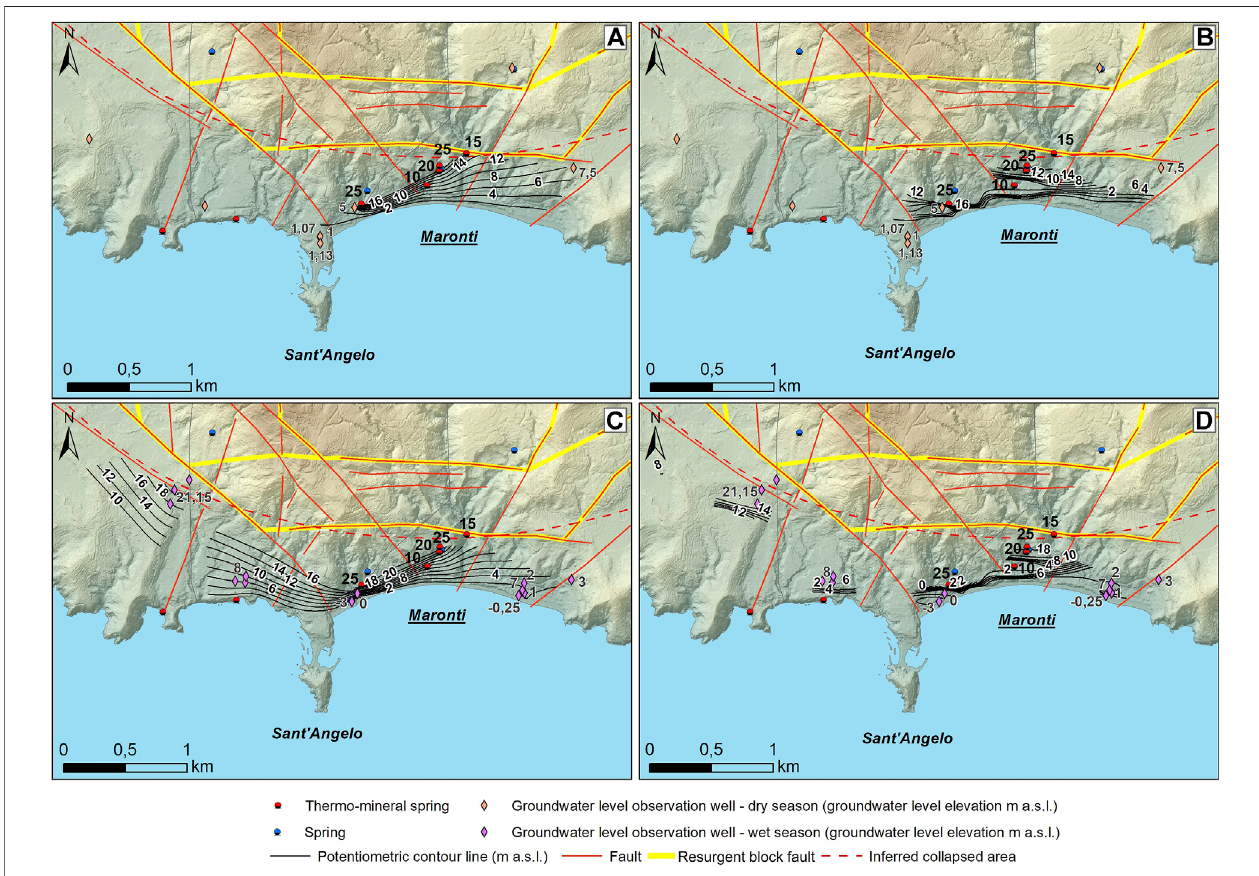
FIGURE 8 | Piezometric surface map of the Maronti sector: (A) NaN interpolation (dry season); (B) IDW interpolation (dry season); (C) NaN interpolation (wet season); (D) IDW interpolation (wet season). DEM details are in Figure 2 .